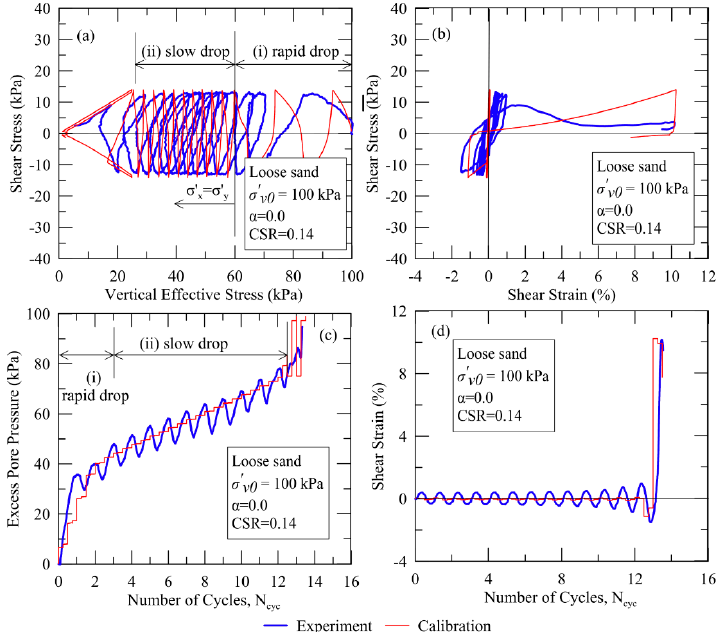
Figure 5. Comparison of the UBCSAND2 model for loose Pohang sand and laboratory CDSS test at CSR = 0.14, σ (cid:48) v0 = 100 kPa, and α = 0.0 in the variations of ( a ) stress path, ( b ) shear stress–strain curve, ( c ) excess pore water pressure generation, ( d ) shear strain and number of cycles to